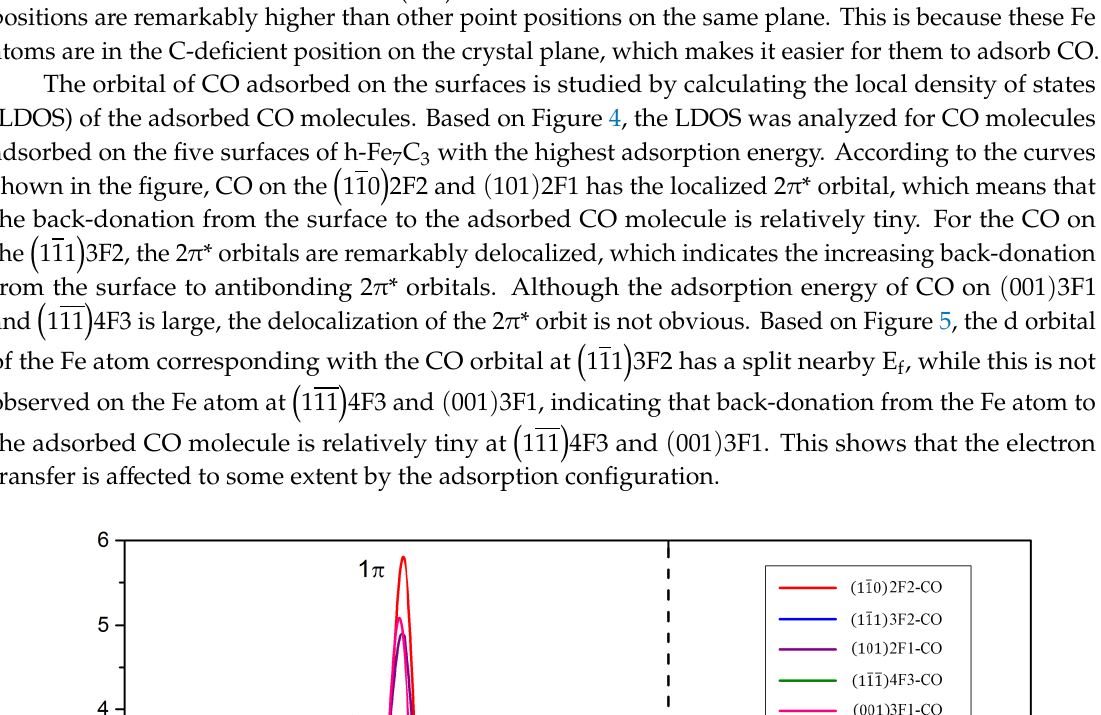
Figure 4. Local density of states (LDOS) of CO adsorbed on the (11(cid:3364)0) 2F2, (11(cid:3364)1) 3F2, (101) 2F1, (11(cid:3364)1(cid:3364)) 4F3 and (001) 3F1 of the h-Fe